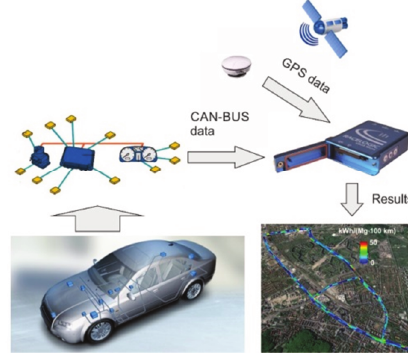
Fig. 1. System used for measurement of car and engine operating